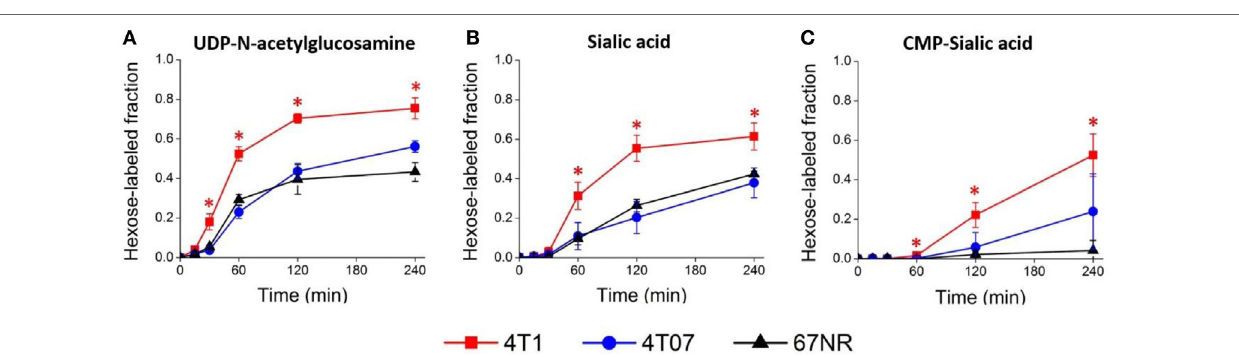
FigUre 5 | Sialic acid metabolism is upregulated in highly metastatic 4T1 cells. Highly metastatic 4T1 cells, slightly metastatic 4T07 cells, and non-metastatic 67NR cells were incubated with 13 C-glucose media and extracted for metabolites at indicated time points. Hexose-labeled fractions of (a) uridine diphosphate (UDP)-N- acetylglucosamine, (B) sialic acid, and (c) cytidine monophosphate (CMP)-sialic acid reflect metabolic flux through the hexosamine-sialic acid pathway and were calculated by summing the isotopic ratios of species showing 13 C-glucose labeled hexose rings. Values are the average of three biological replicates at each time point. Error bars represent SD. Time points showing statistically significant difference ( p -value < 0.05) between 4T1 and the other two cell lines are marked with asterisks